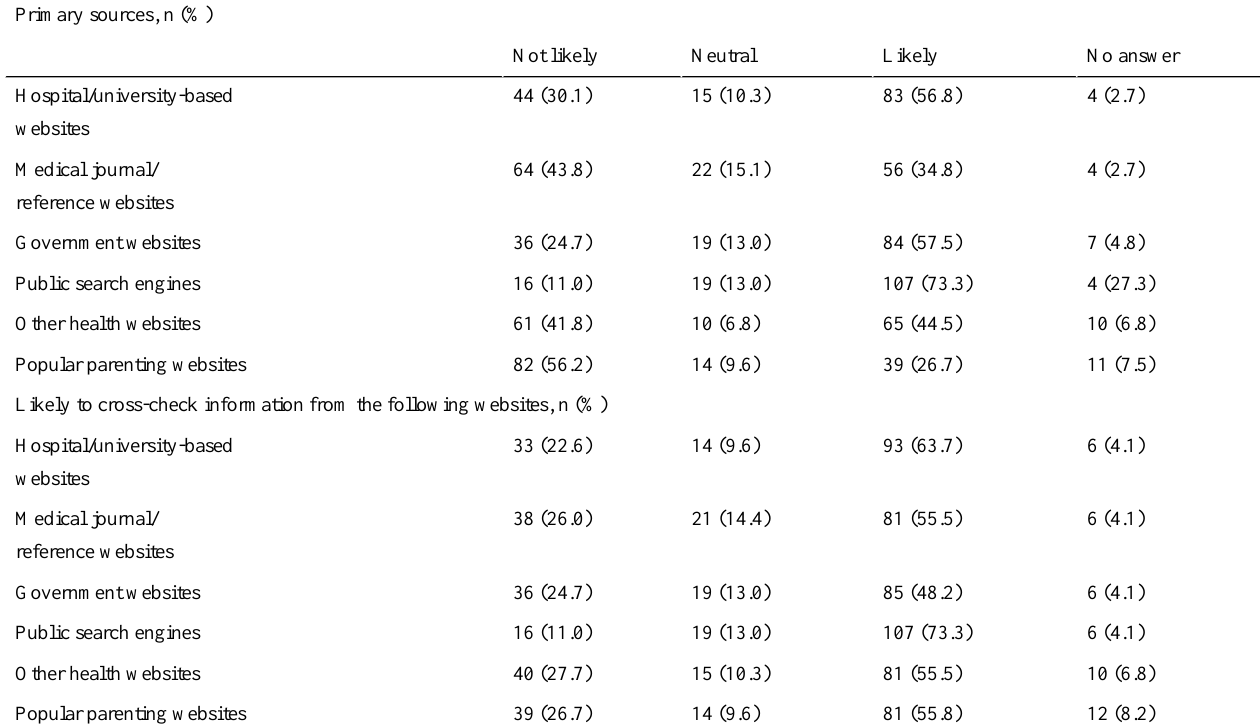
Table 3. Websites parents were likely to use in the future for their child health information and crosscheck information they found. Primary sources, n